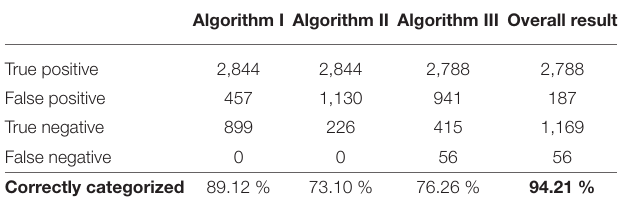
TABLE 4 | Results of the algorithms with respect to the testing data